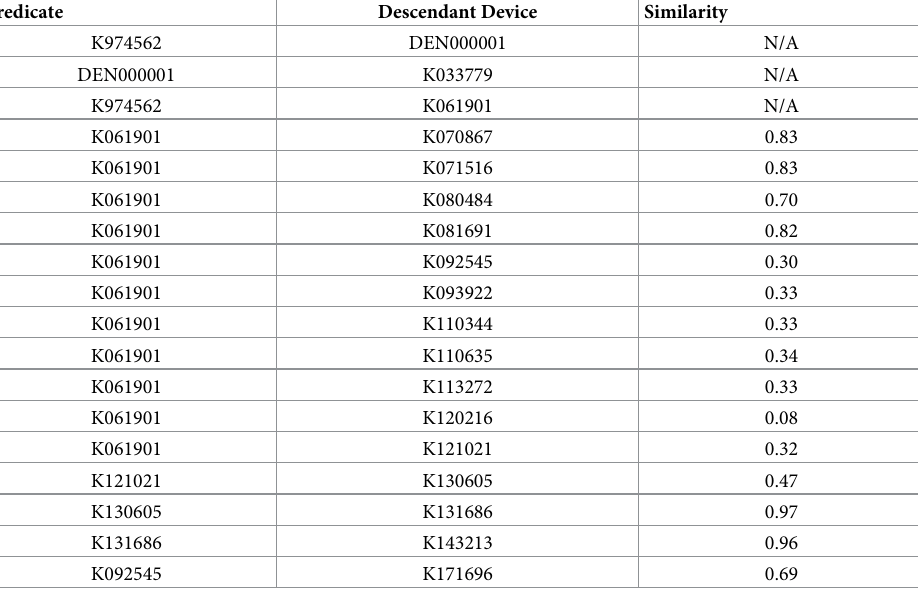
Table 1. Similarity score for devices descendant from the predicate ancestral tree for the ProCode: MRN.